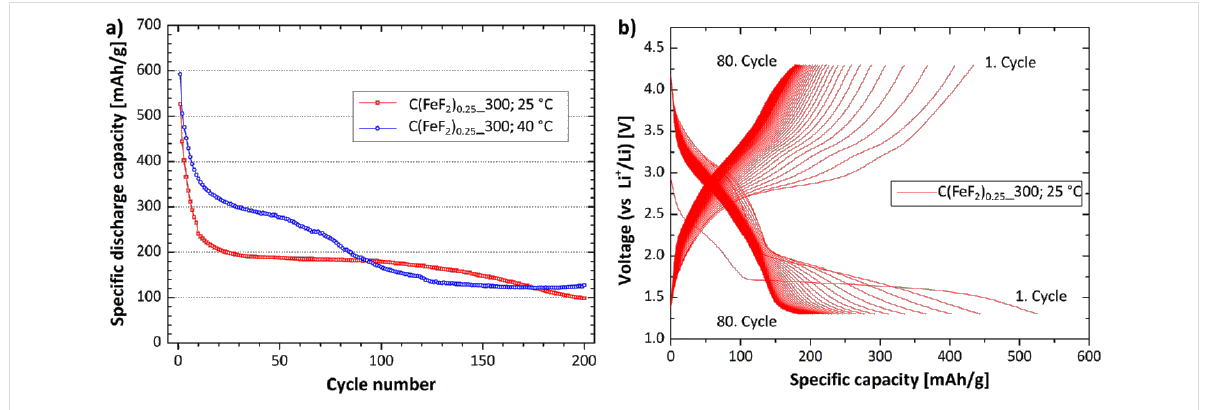
Figure 9: Long time cycling of C(FeF 2 ) 0.25 _300. a) Specific discharge capacity at different temperatures, b) Charge/discharge profile. The samples were cycled with a current density of 25